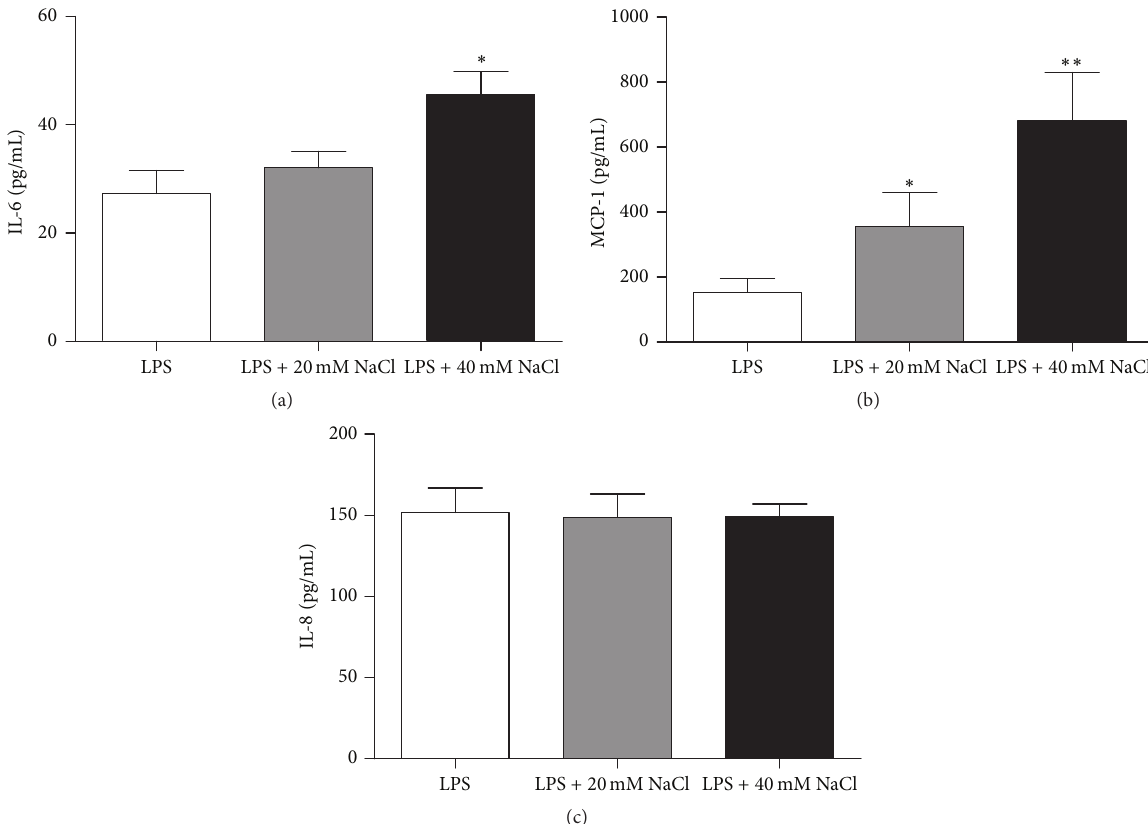
Figure 2: NaCl promotes the secretion of IL-6 and MCP-1 by ARPE-19 cells but had no effect on the production of IL-8. Cells precultured with serum-free medium for 24 h and then stimulated by LPS and cultured with medium alone or medium with an extra addition of NaCl (20 mM and 40 mM) for 24h. The concentration of IL-6 ((a) 𝑛 = 7 ), MCP-1 ((b) 𝑛 = 8 ), and IL-8 ((c) 𝑛 = 8 ) in cell culture supernatants was measured by ELISA. ∗ 𝑃 < 0.05 and ∗∗ 𝑃 < 0.01 for comparison with control and NaCl-treated ARPE-19 cells. The data are expressed as mean ± SD of three independent experiments. Paired-samples t -test (when the difference between the two tested groups conforms to normal distribution) or Wilcoxon matched-pairs test (when the difference between the two tested groups does not conform to normal distribution) was used for statistical analyses for LPS control versus LPS + 20 mM NaCl or LPS + 40 mM NaCl in each